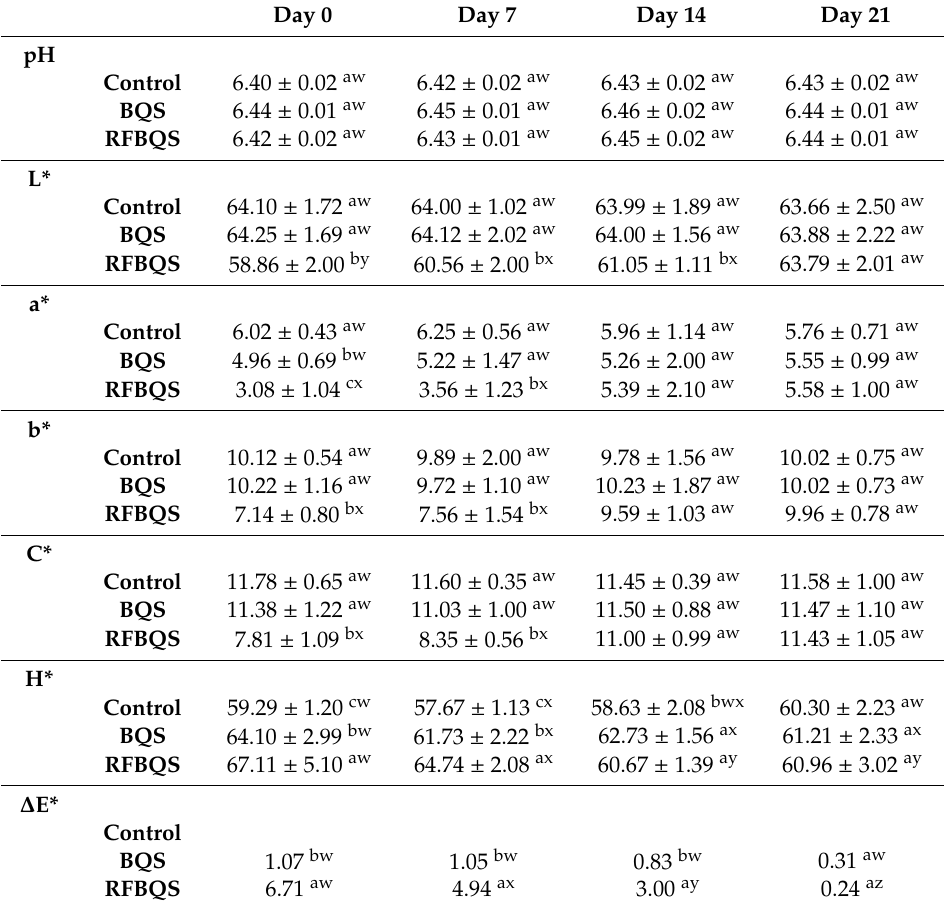
BQS: sausage with 3% black quinoa seeds; RFBQS: sausage with 3% fibre-rich fraction from the wet-milling of black quinoa seeds. a–c Di ff erent letters in the same column indicate significant di ff erences ( p < 0.05). w–z Di ff erent letters in the same row indicate significant di ff erences ( p <